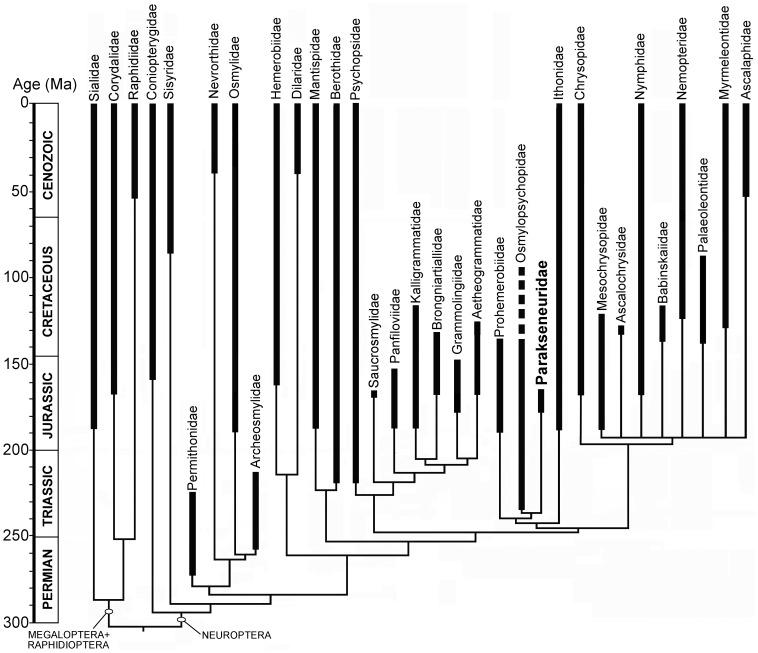
The phylogenetic relationships of 33 families of Neuropterida based on the combined morphological and DNA sequence data.Divergence time is inferred from the results of molecular divergence time estimates from [24]. Fossil age of each family is based on all available paleontological data, both published and unpublished.